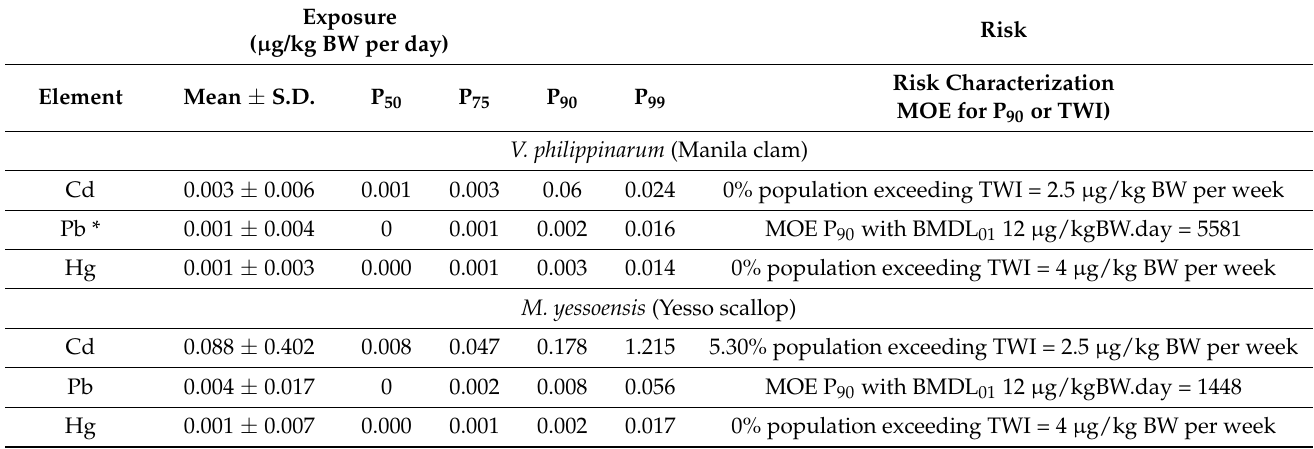
Table 2. Chronic probabilistic exposure (P 50 to P 99 percentile) (expressed as µ g/kgBW per day–* UB scenario) to toxic elements (Cd, Pb, and Hg) for the Korean population, by consumption of V. philippinarum (Manila clam) and M. yessoensis (Yesso scallop) and derived risk characterization, based on available toxicological limits. (MOE = Margin of exposure; TWI = Tolerable weekly